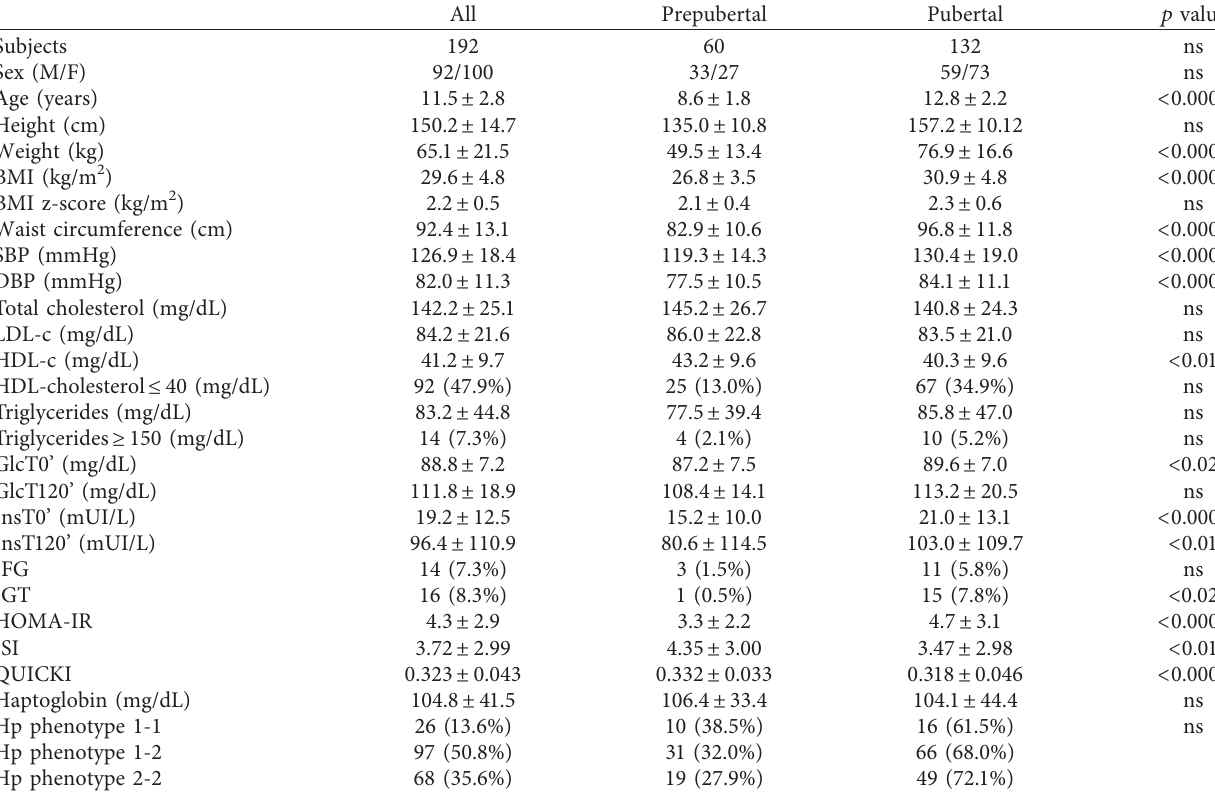
Table 1: Clinical and biochemical characteristics of the